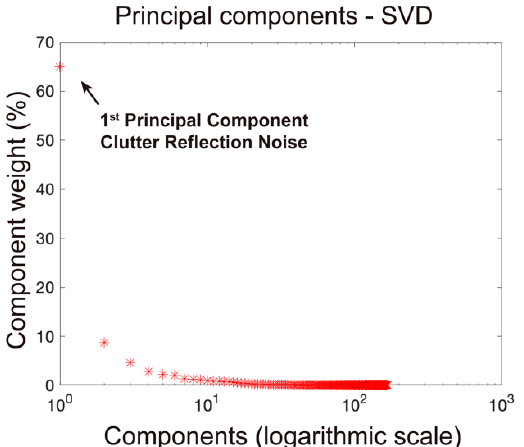
Figure 6. Principal components of a B-scan obtained by SVD after the application of the 2D Fourier transform. The first principal component is dominant (65%). The remaining components have a weight less than 10% each.